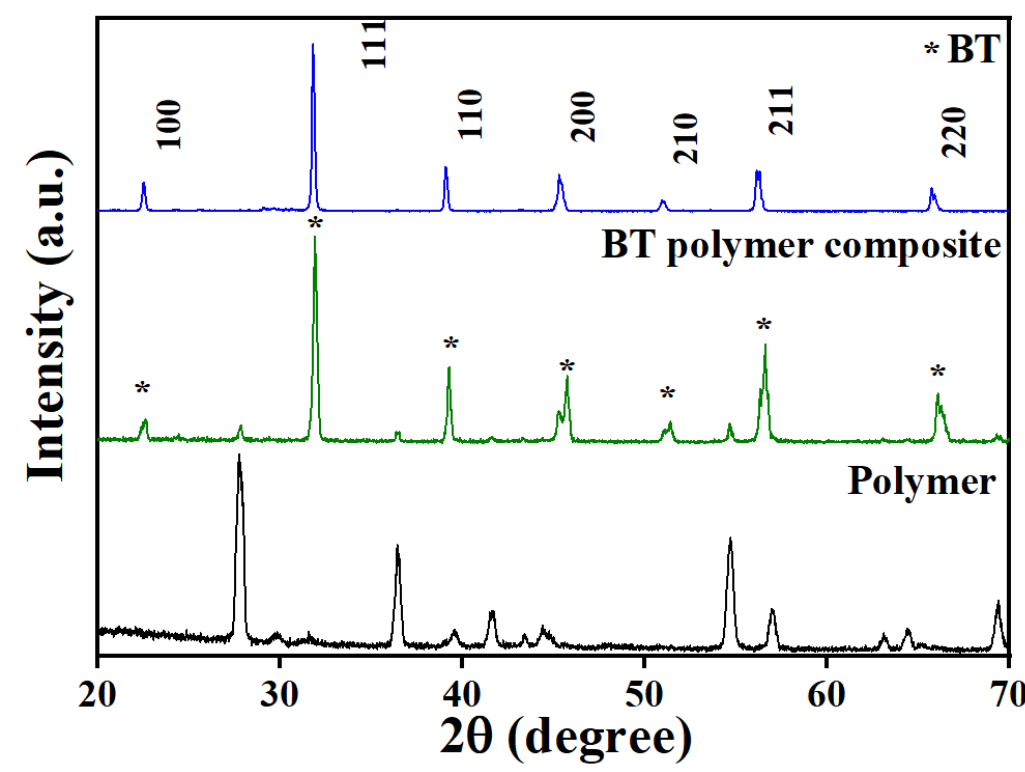
Figure 1. XRD patterns of BaTiO 3 ceramics powder, BaTiO 3 -polymer composite sample and polymer Figure 1. XRDpatternsofBaTiO 3 ceramicspowder, BaTiO 3 paint.